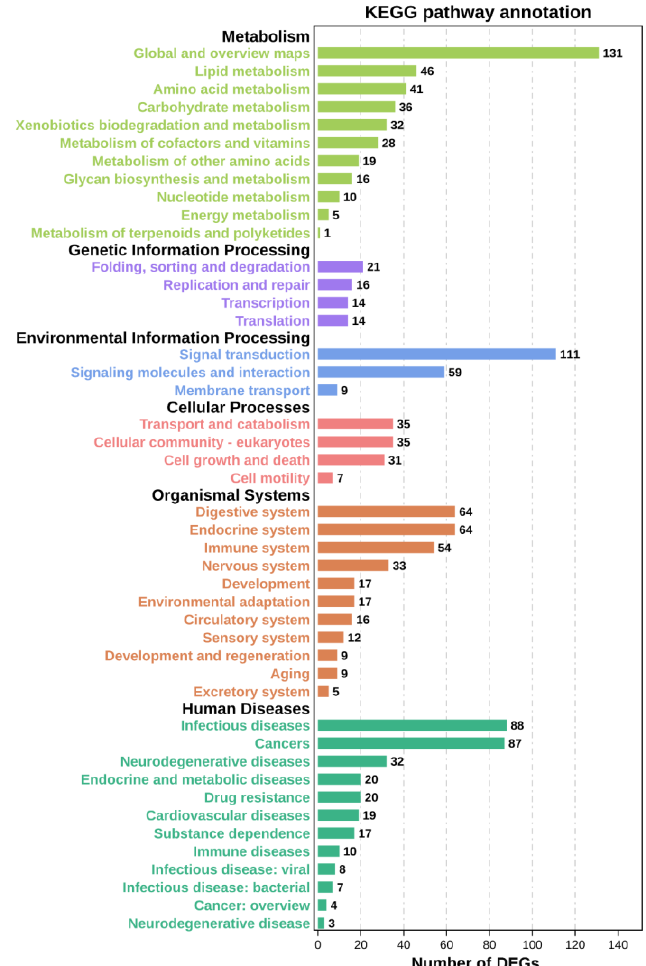
Figure 4. Top 10 significant GO terms. Ordinate indicates DEG numbers; abscissa stands for specific terms.